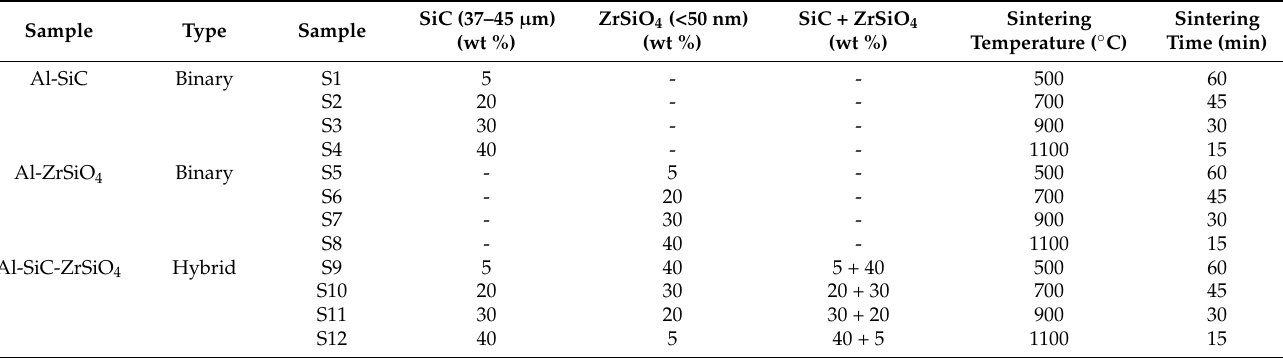
Table 2. Sintering temperature and sintering time for the